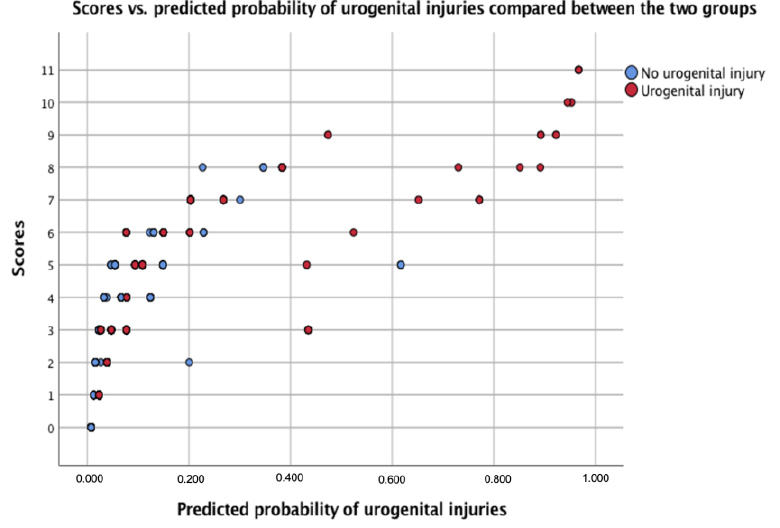
Figure 2. Assessment of the proposed UPPS score. Scatter blot demonstrating UPPS score vs. predicted probability of urogenital injuries, compared between patient groups with and without urogenital injuries.